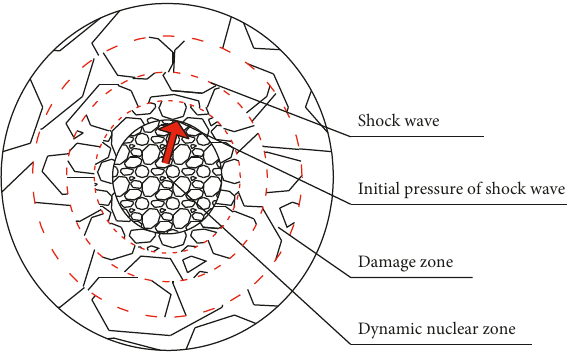
Figure 5: Damage zone formation process.